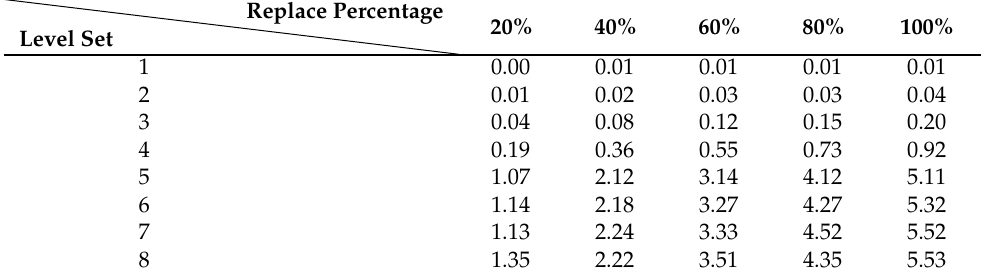
Table 12. Pressure error of substituting the 5th stage.